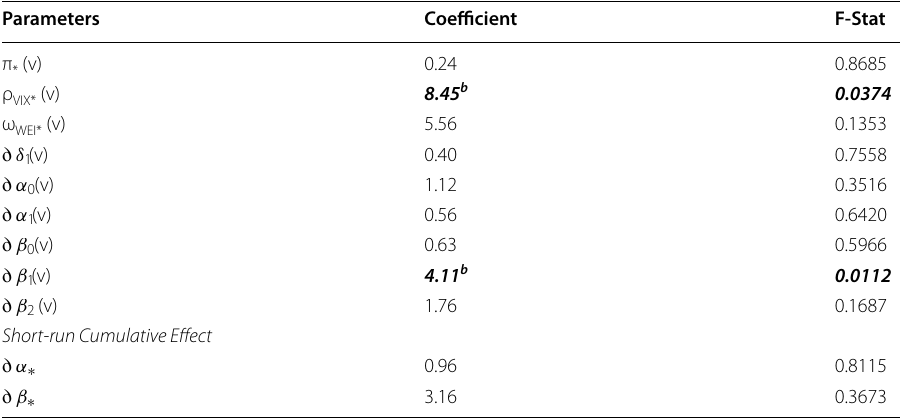
Table 4 Wald test